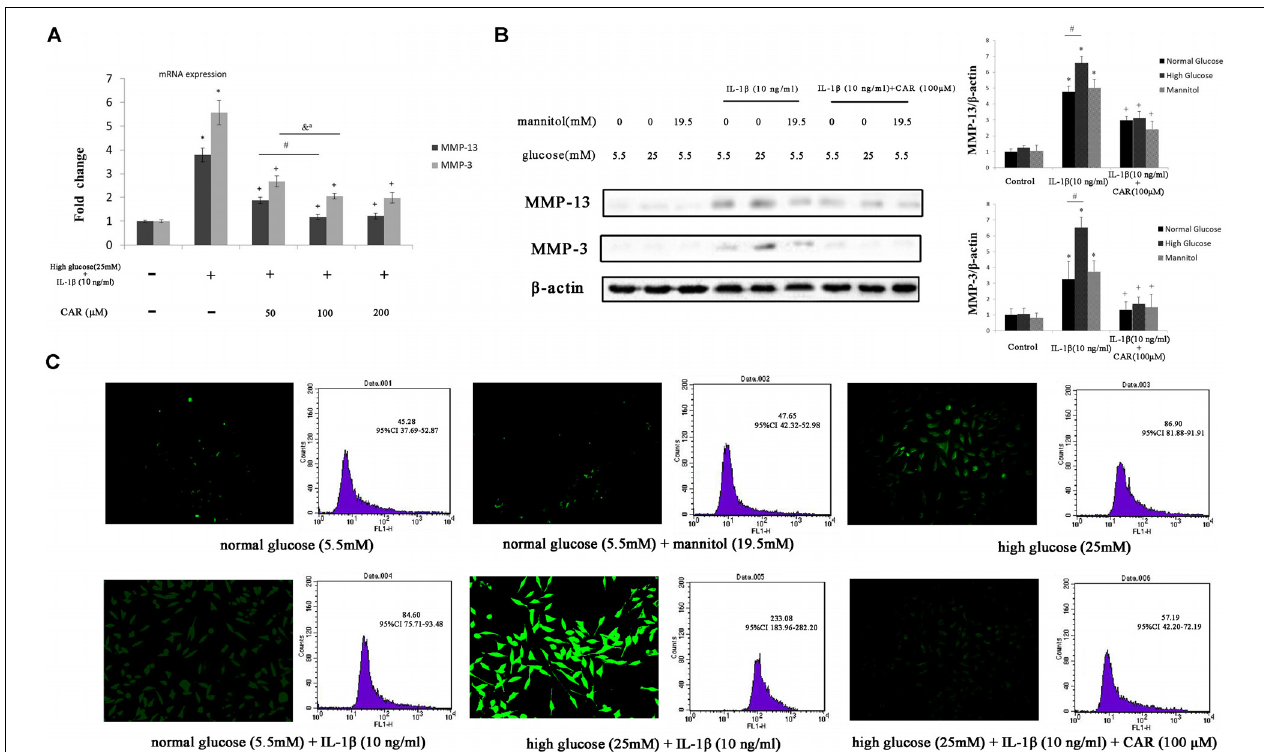
FIGURE 6 | qPCR, western blotting, and ROS in FLSs. (A) Relative expression of MMP-3 and MMP-13 mRNA. Differences between the control group and high glucose (25 mM) with IL-1 β (10 ng/ml) group were significant ( ∗ P < 0.001); differences between the high glucose (25 mM) with IL-1 β (10 ng/ml) group and different doses of CAR were significant ( + P < 0.001); differences between CAR (50 µ M) and CAR (100 µ M) were significant ( # P < 0.001 and &a P = 0.001), but no significant differences were observed between CAR (100 µ M) and CAR (200 µ M). One-way ANOVA, n = 9; means with 95% confidence intervals. (B) The western blotting results of MMP-3 and MMP-13 in FLSs. Data were obtained from three separate experiments. β -actin was the internal standard. Differences between the groups were significant ( ∗ P < 0.001, + P < 0.001, and # P < 0.001). One-way ANOVA, n = 3; means with 95% confidence intervals. (C) The fluorescence microscopy and flow cytometry of ROS in FLSs. n = 3; means with 95% confidence